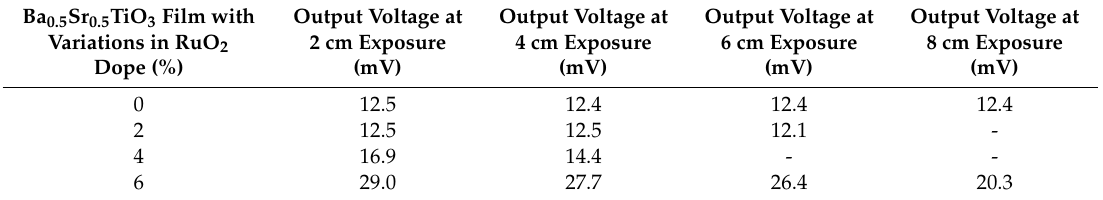
Table 1. The voltage output measurement data of Ba 0.5 Sr 0.5 TiO 3 film doped with RuO 2 as a bad breath gas sensor with variations in the gas exposure distance: 2 cm, 4 cm, 6 cm and 8 cm.